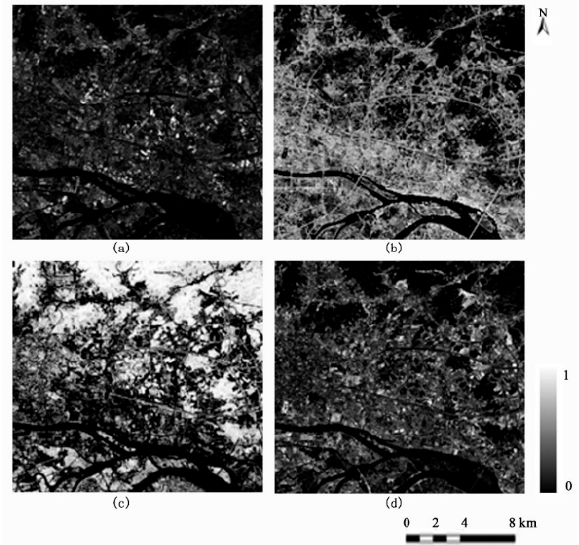
Figure 5. Four fractional images unmixed through LSMA: ( a ) high-albedo, ( b ) low-albedo, ( c ) vegetation, and ( d ) bare soil.